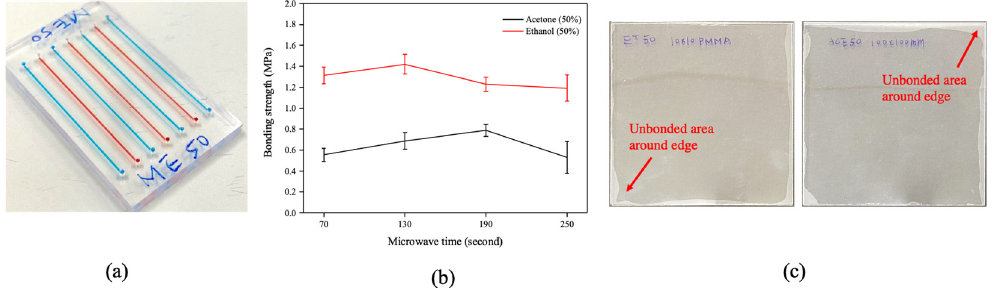
Figure 9. ( a ) Multiplex parrel microfluidic device bonded by a microwave-assisted solvent bonding process (chip size: 3 × 5 cm). ( b ) The bonding strength with different microwave irradiation times from 70 to 250 s. The error bars in the figure were obtained from more than 3 individual experiments. ( c ) Large (10 × 10 cm) PMMA substrate bonding with ethanol (left) and acetone (right). Both ethanol and acetone concentrations were 50%, and microwave irradiation time was 130 s.